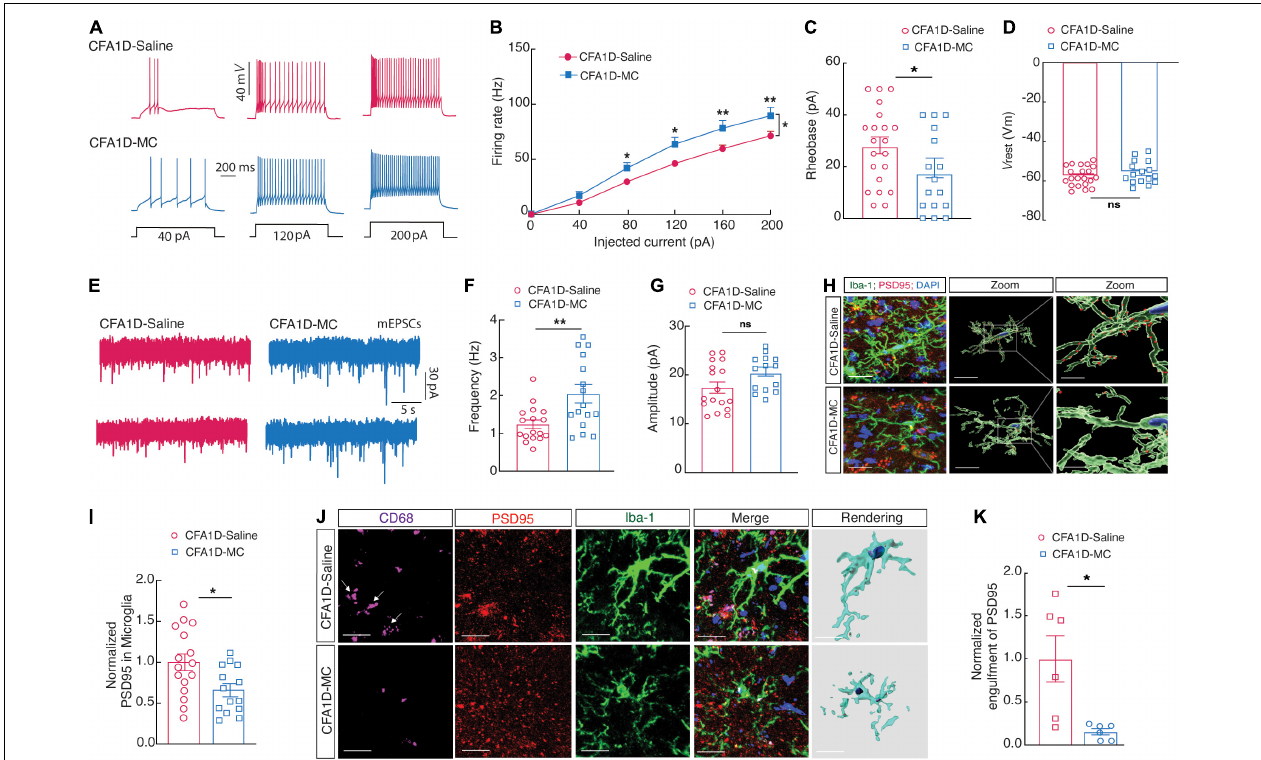
FIGURE 6 | Blockade of microglial activation affects ZI VGABA activity and microglial engulfment of ZI V neuronal spines in CFA1D mice. (A) Sample traces and (B) summarized statistical data for action potential firing recorded from ZI VGABA in CFA1D mice treated with saline or minocycline. Two-way ANOVA with Bonferroni post-tests [Time × group interaction, F (5,175) = 3.78 and P = 0.0028]. (C,D) The alterations in action potential properties in (C) rheobase ( t 35 = 0.98 and P = 0.33); (D) V rest (mV) ( t 26 = 0.98 and P = 0.33); (E) sample traces of the mEPSCs from CFA1D mice treated with saline or minocycline. (F,G) Summarized statistical data of (F) the frequency ( t 31 = 3.05 and P = 0.0046); (G) the amplitude ( t 30 = 1.92 and P = 0.06) of CFA1D mice treated with saline or minocycline. Action potential parameters were estimated from the initial evoked spike. n = 16–21 neurons per group. (H) Representative images and quantification of Iba-1 + microglia (green) containing PSD95 + puncta (red) in the ZI V from CFA-treated mice treated with minocycline or saline. Scale bars, 10 µ m (overview) and 2 µ m (inset and